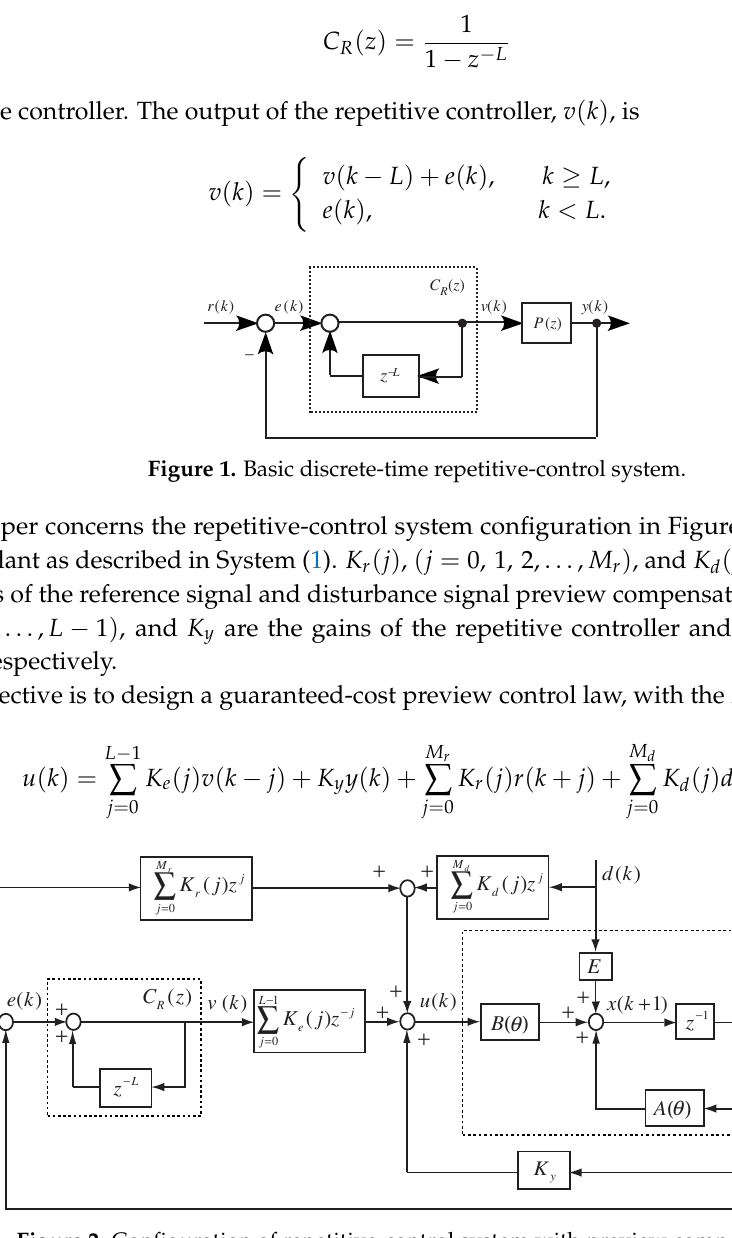
Figure 2. Configuration of repetitive-control system with preview